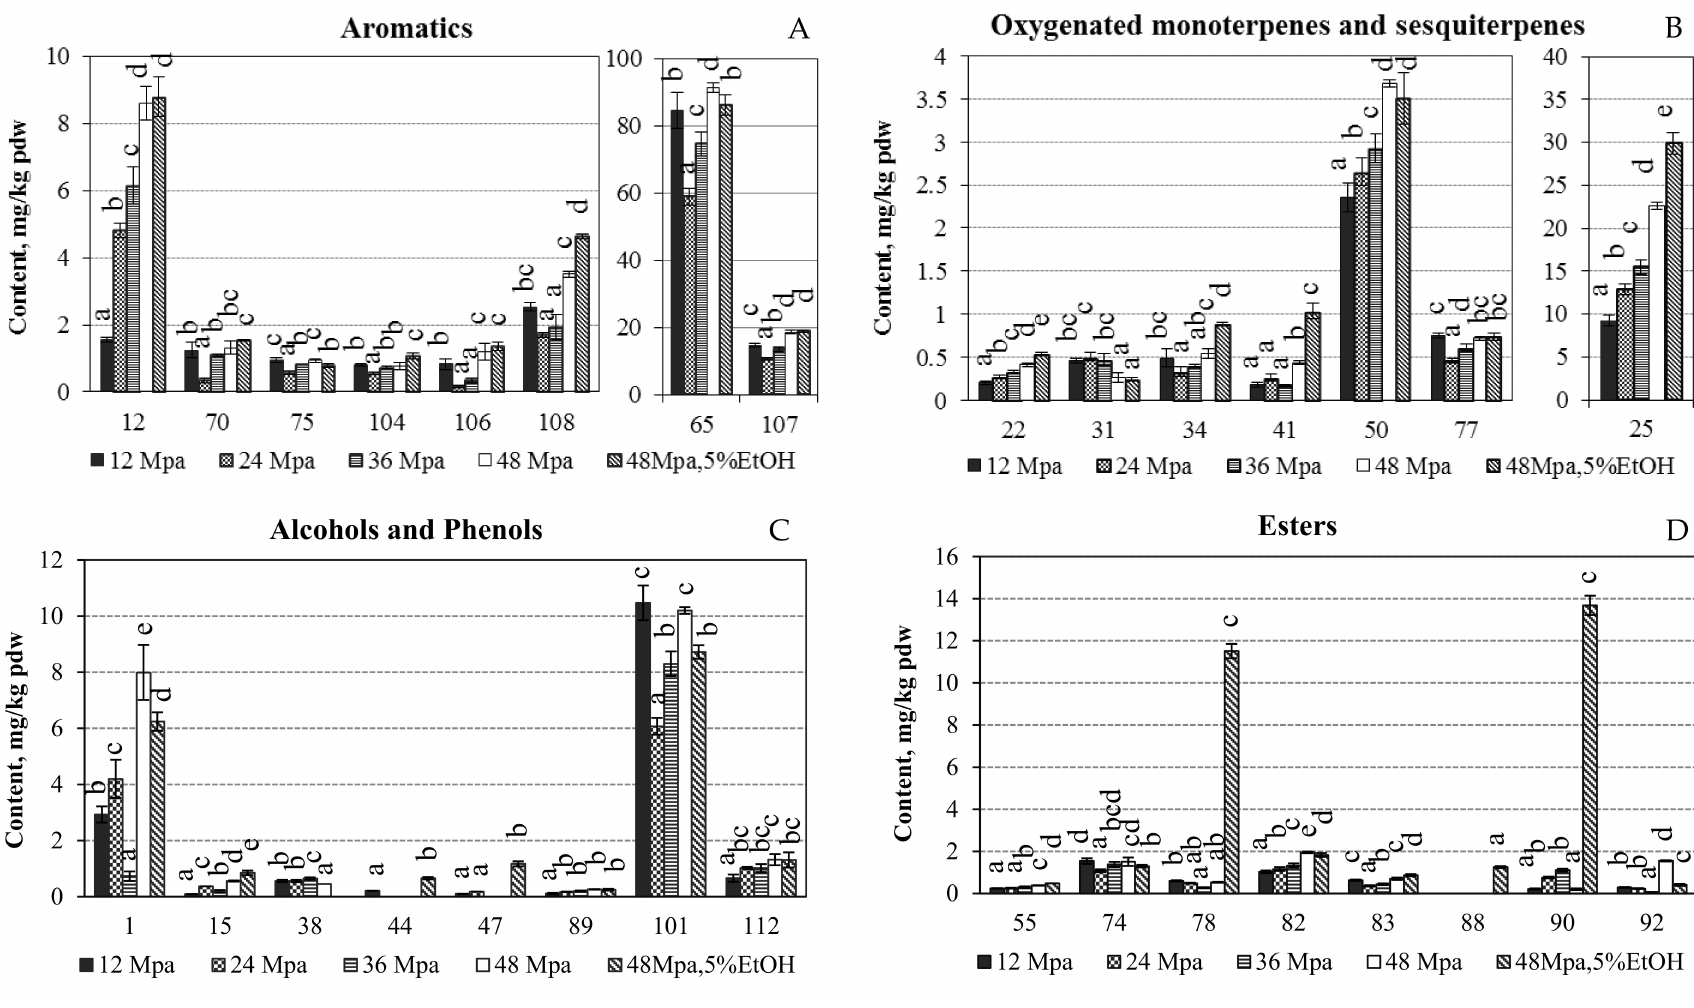
Figure 1. The absolute amounts of the main volatile compounds of major classes (( A )—Aromatics, ( B )—Oxygenated monoterpenes and sesquiterpenes, ( C )—Alcohols and phenols, ( D )—Esters) of Narcissus poeticus SFE-CO 2 extracts, in mg/kg pdw. Constituents are numbered by the same order as provided in Table 2. Values within columns followed by the same letter (a–e) do not differ statistically at p < 0.05 (Duncan